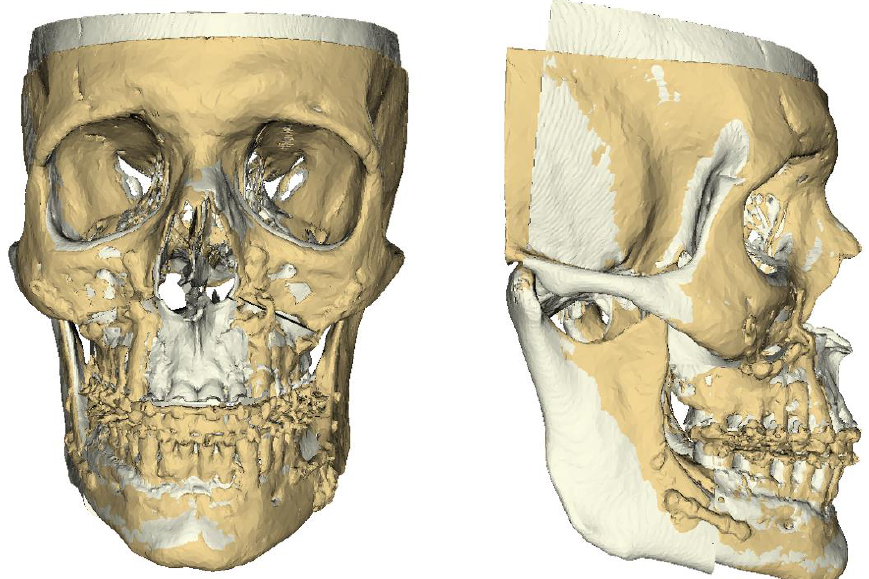
Figure 2. Approximation of the postoperative model (beige) to the virtual planning model (white) using the “Transforms” tool, in the frontal ( left ) and lateral ( right ) views.